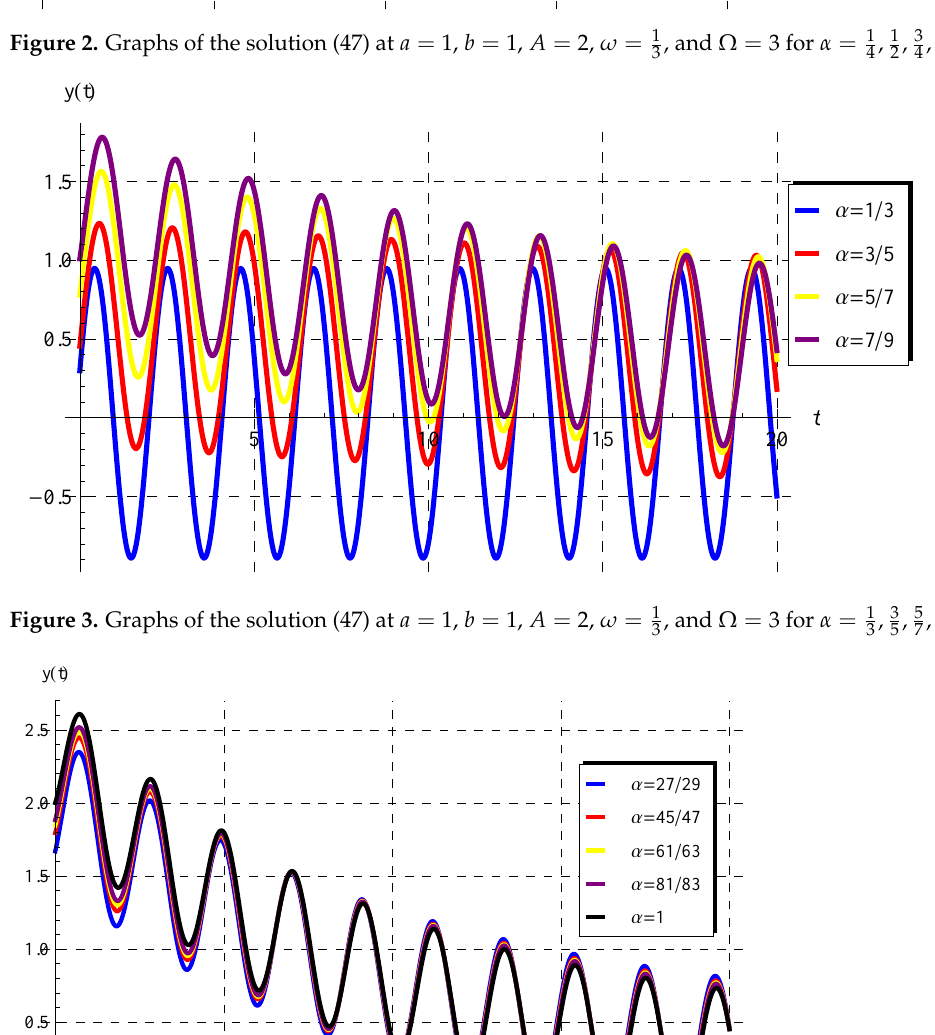
Figure 2. Graphs of the solution (47) at a = 1, b = 1, A = 2, ω = 1